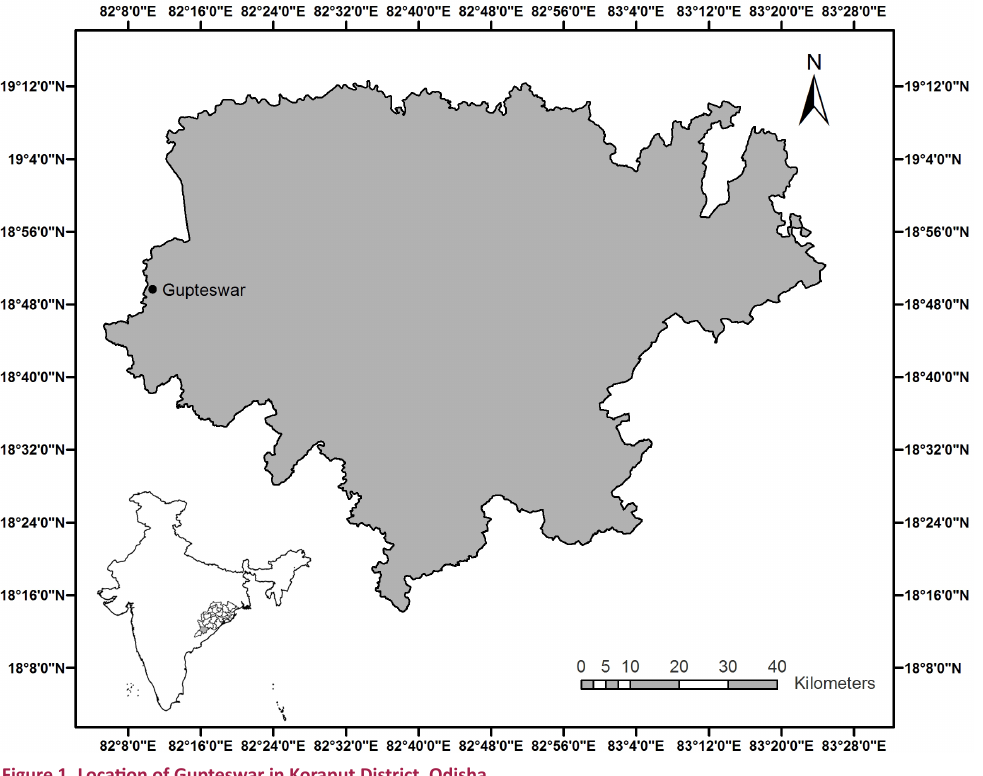
Figure 1. Location of Gupteswar in Koraput District, Odisha.